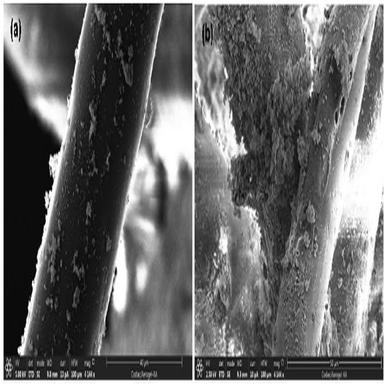
SEM images of CDC/ARG before (a) and after (b) 60Co exposure.